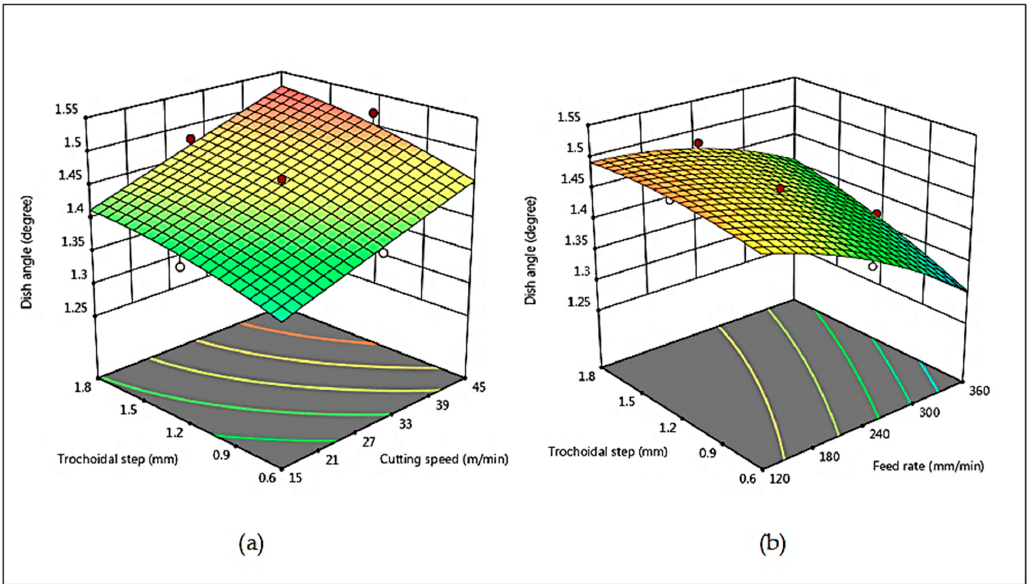
Figure 10. Combined e ff ects of ( a ) v c and s tr on Dish angle ( b ) v f and s tr on Dish angle.